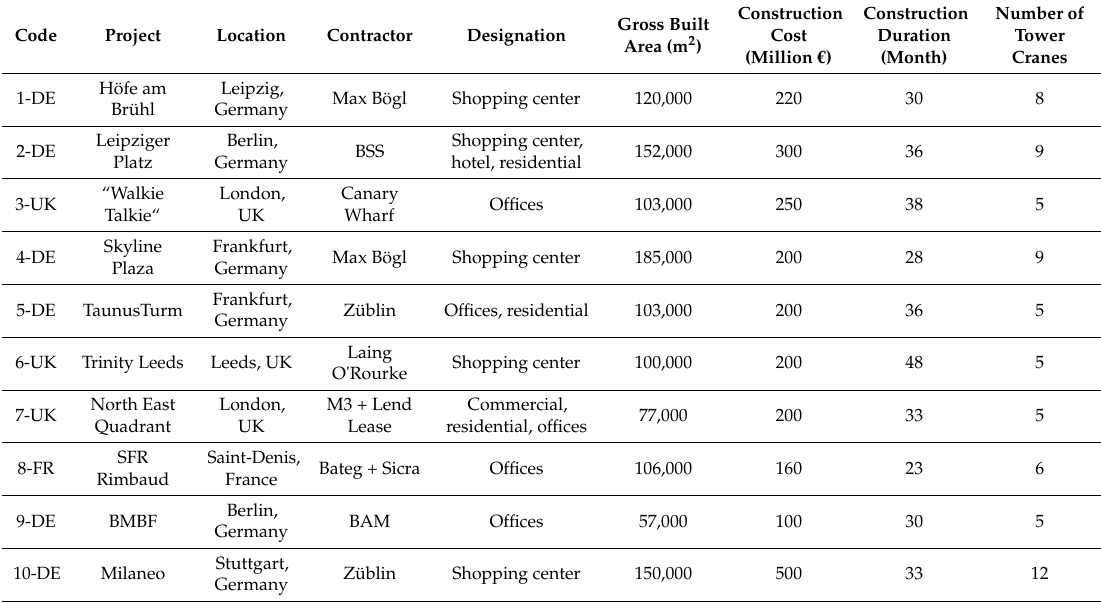
Table 1. Profile of